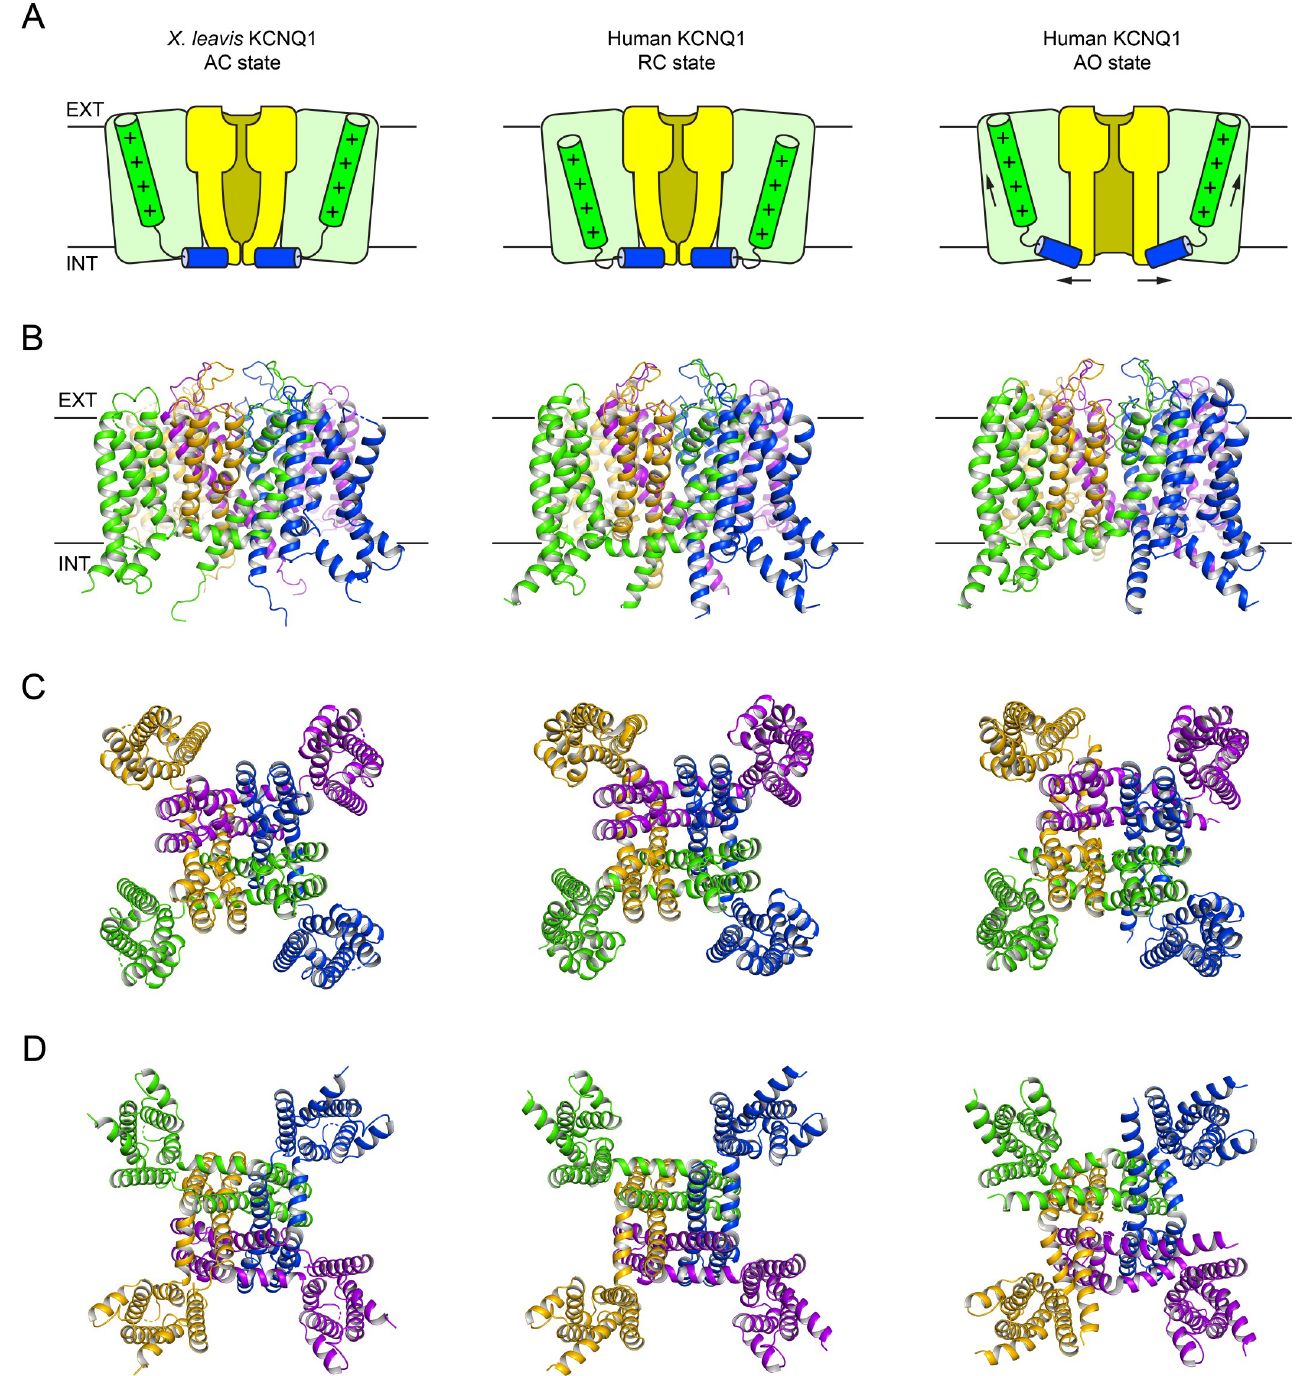
Fig 1. Overall architecture of the X . leavis KCNQ1 structure and human KCNQ1 homology models. ( A ) Schematic cartoon depicting the functional states of the VSD (light green box) and PD (light yellow box). The S4 helix (with positive gating charges “+”) and S4-S5 linker helix are shown as green and blue cylinders, respectively. The X . leavis KCNQ1 structure is in a decoupled state with an activated VSD and closed PD. Homology models of human KCNQ1 were developed with the VSD / PD in the resting / closed (RC) and activated / open (AO) conformation. Black arrows illustrate conformational changes during voltage-dependent channel activation. ( B ) Side view of the KCNQ1 channel models. The approximate position of the membrane bilayer is indicated by vertical lines and the extracellular and intracellular sides are labeled EXT and INT, respectively. ( C )+( D ) View of the KCNQ1 channel models from the extracellular and intracellular side,